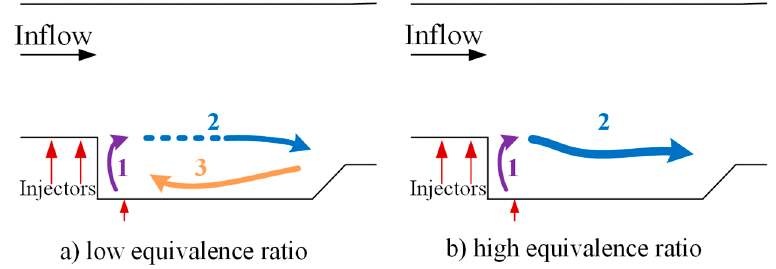
Figure 5. Schematic of the different initial flame propagation routines during the ignition process.